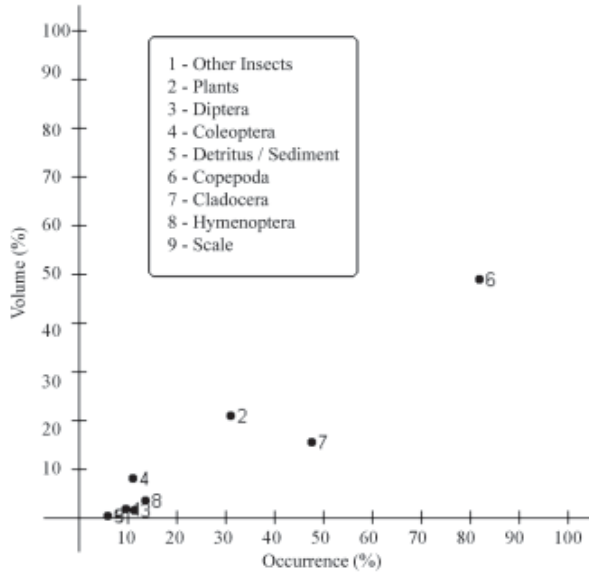
Fig. 2. Proportion of the food items in the diet of the O. bonariensis representing by Costello’s